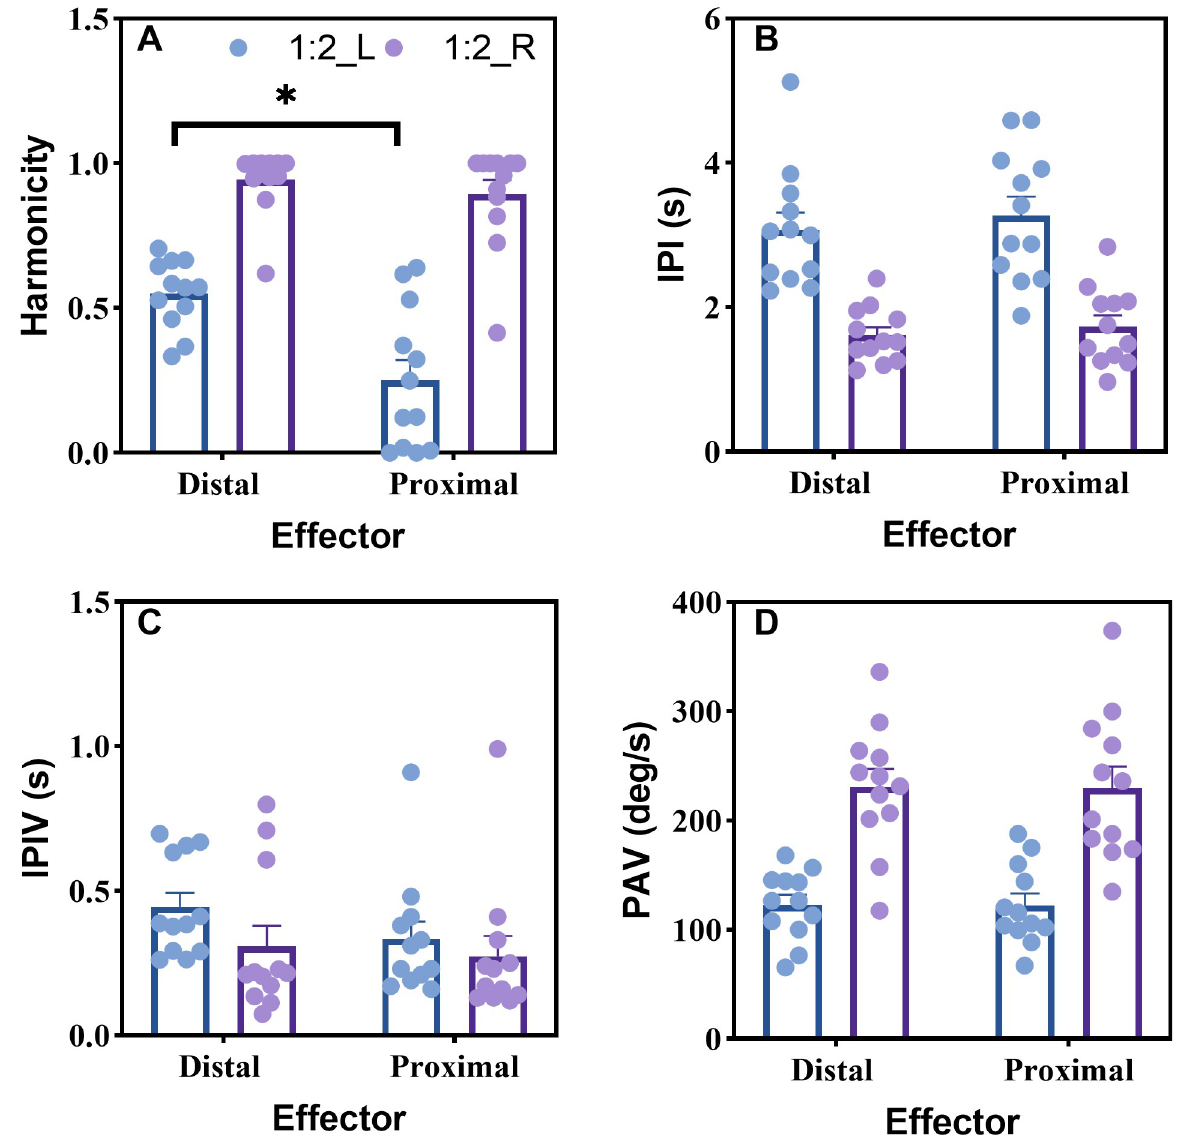
Fig 4. Unimanual measures. (a) Force harmonicity, (b) mean inter-peak interval, (c) standard deviation of inter-peak interval, and (d) phase angle velocity. The error bars represent standard error of the mean (SEM) and � depicts a statistical significance level of less than 0.05. Note that harmonicity for the non-dominant effector was significantly lower for the proximal condition compared to the distal condition.